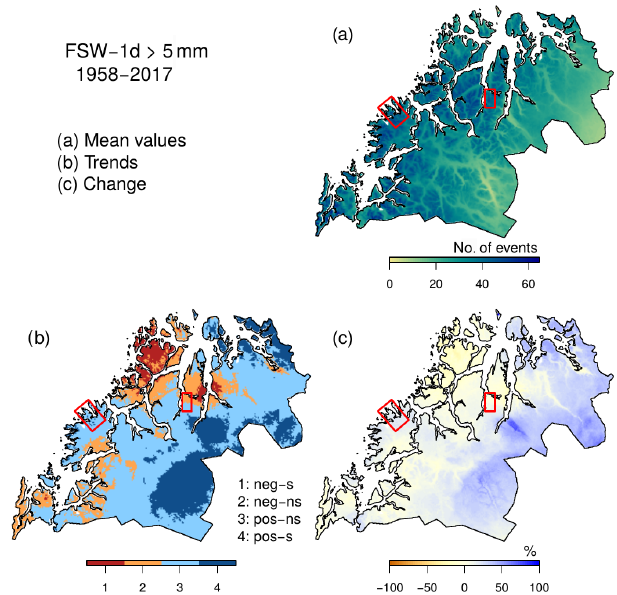
Figure 10. Frequency of 1d snowfall exceeding 5mm during winter (October–April) for the period 1958–2017, based on fresh snow wa- ter equivalent for 1d duration (FSW-1d > 5mm). Mean values (a) , trends (b) and changes are shown in the same way as in Fig. 4.